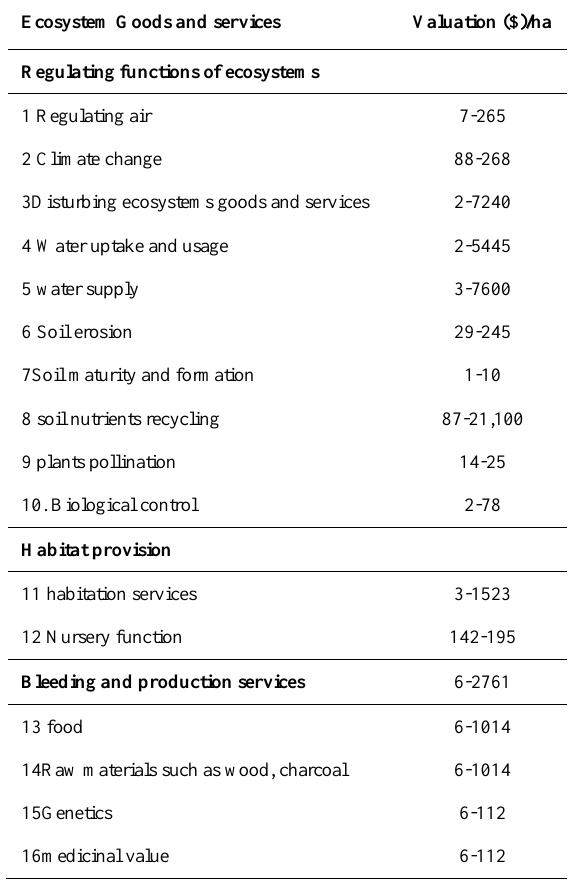
Table 4. Valuation of Ecosystem Goods and Services